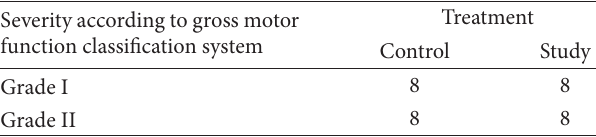
Table 1: Description of block randomization. Severity according to gross motor function classification